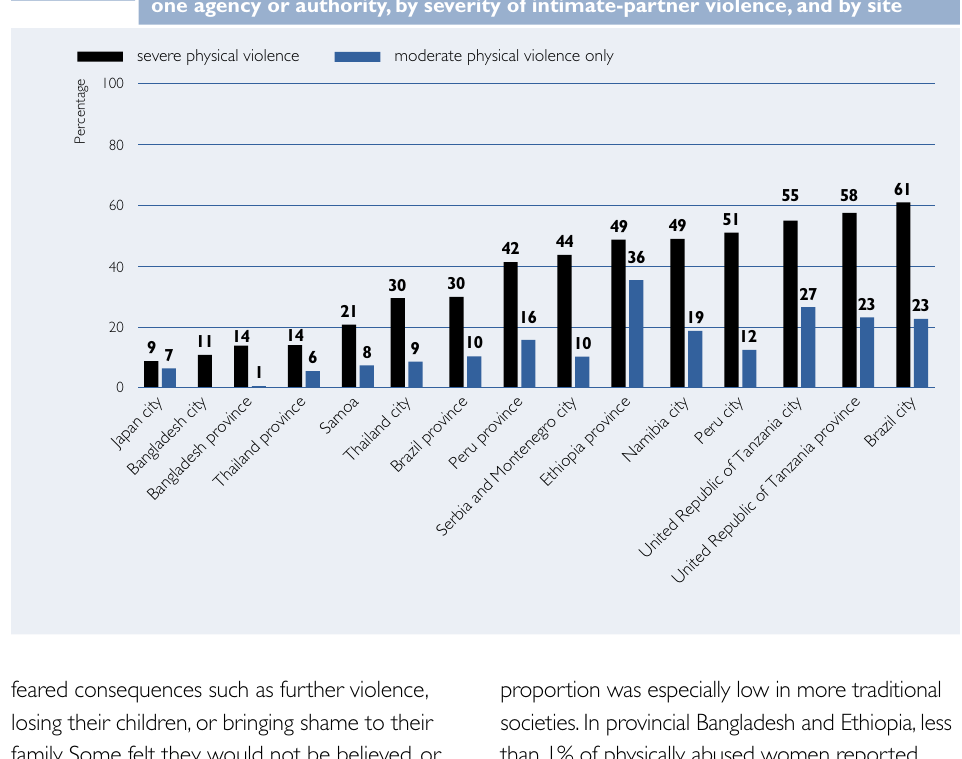
Figure 15 Percentage of ever physically abused women who sought help from at least one agency or authority, by severity of intimate-partner violence, and by site moderate physical violence